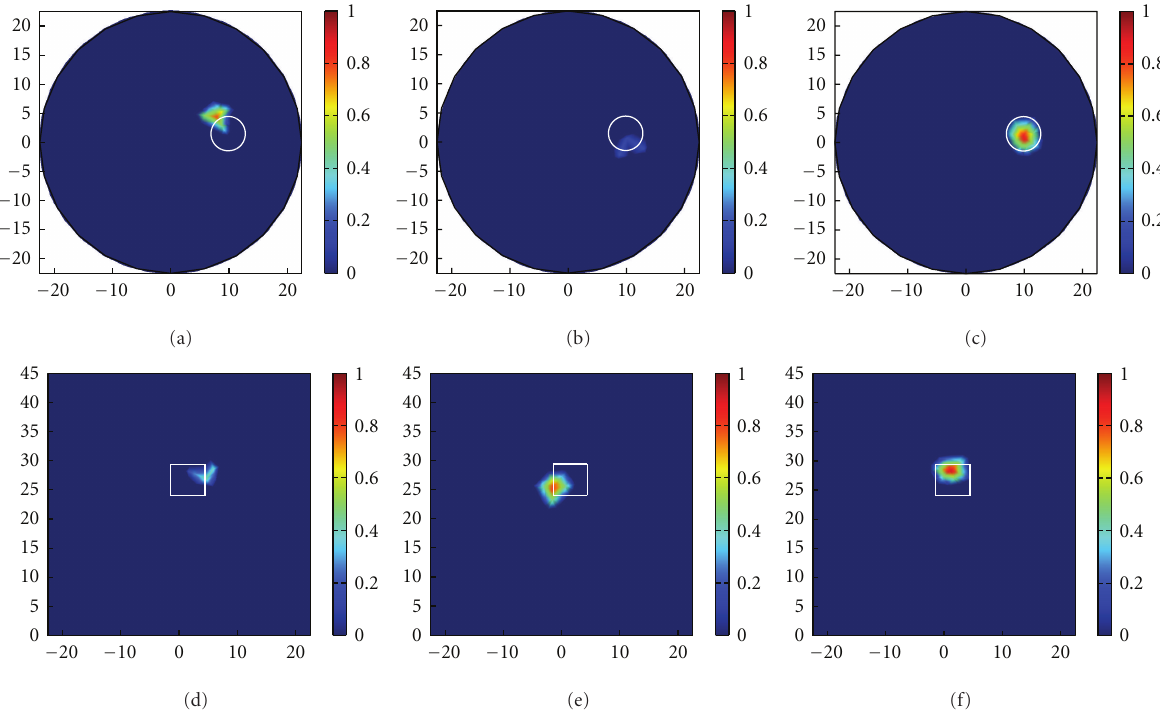
Figure 7: Reconstructed results in physical experiment: (a)–(c) are the x – y views at z = 28mm plane of the reconstructed results using Tikhonov + GCV, TTLS + MGCV, and TTLS + IGCV method, respectively; (d)–(f) are the y – z views at x = 9 . 5mm plane of the corresponding results, where the white contours indicates the real